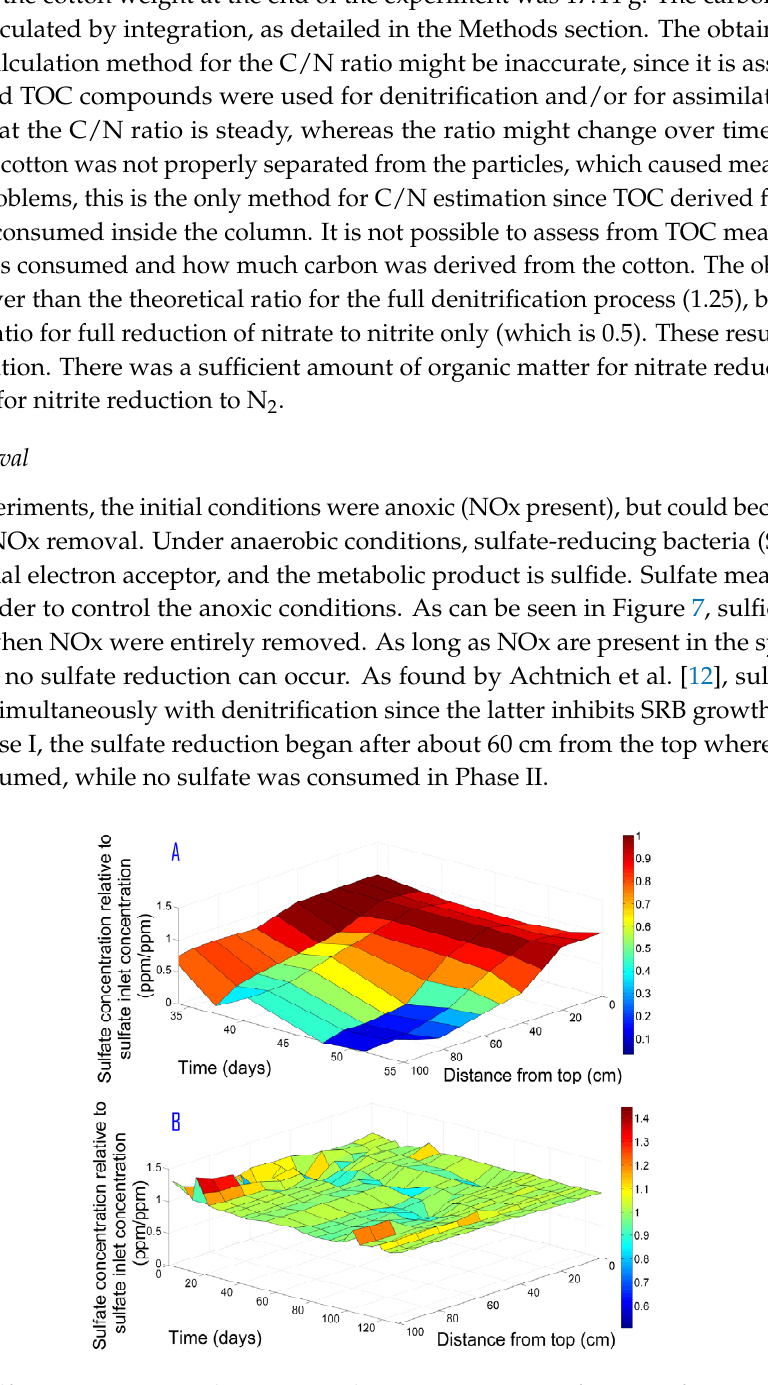
Table 1. Summary of biofilter performance in Phase I and Phase II.